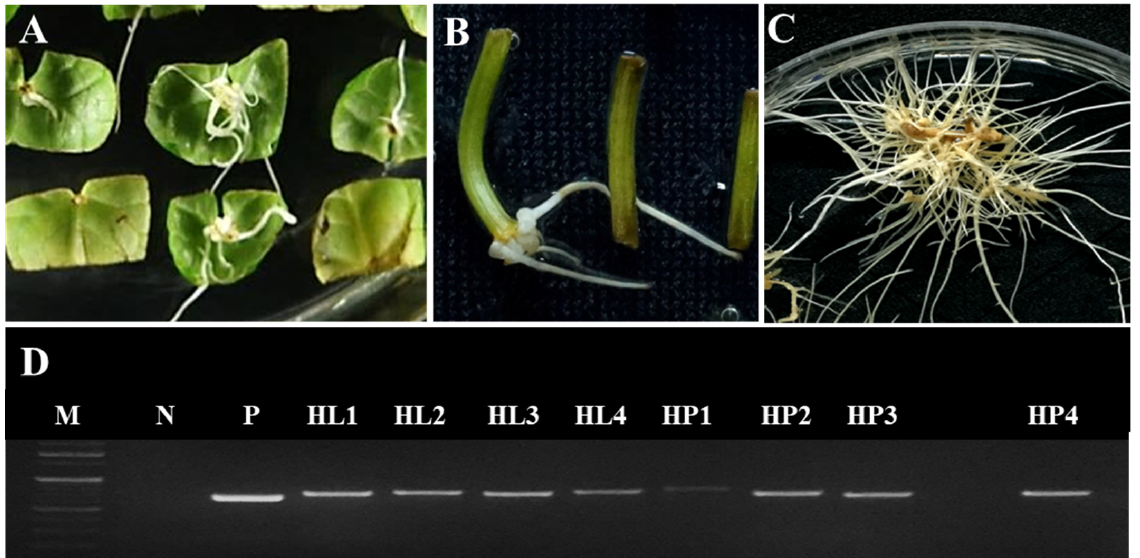
Figure 1. Induction of hairy roots (HRs) in Centella asiatica using Agrobacterium rhizogenes strain KCCM 11879 after 3 weeks of culture. ( A , B ) HR induction from leaf explants ( A ) and petiole explants ( B ); ( C ) HR proliferation; ( D ) PCR analysis of the rolB gene from HR lines. M, ladder; N, negative control (non-transformed root); P, positive control ( Agrobacterium rhizogenes ); HL1–4, HR lines derived from leaf explants; HP1–4, HR lines derived from petiole